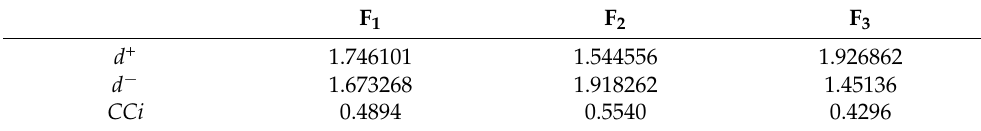
Table 12. Closeness coefficient ( CCi ).